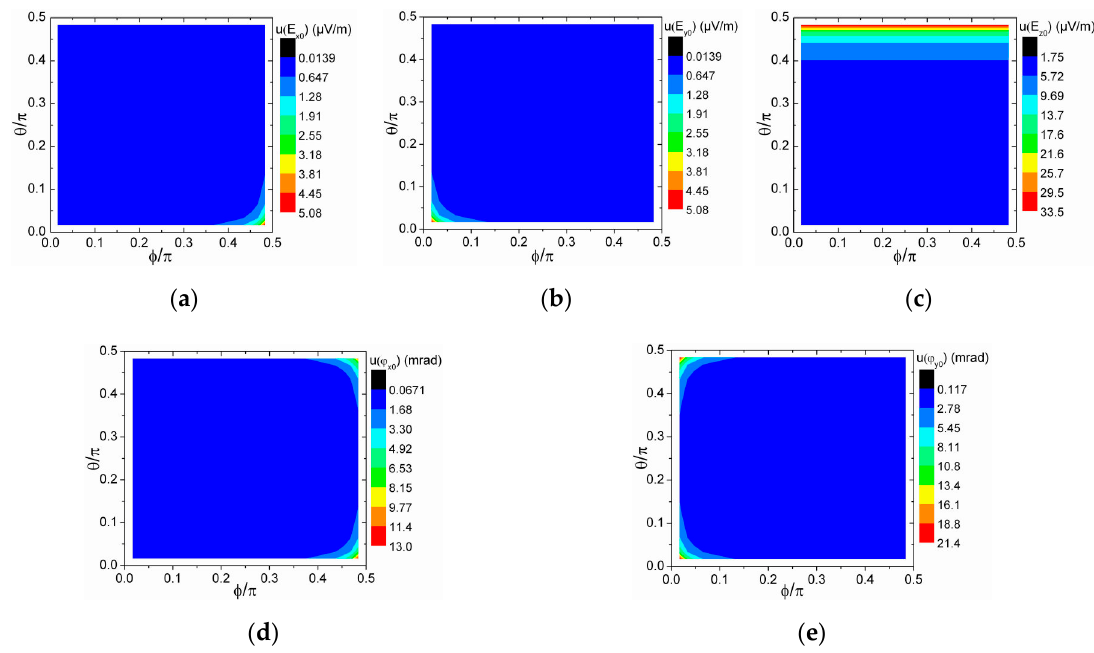
Figure 4. Estimated uncertainties of the amplitudes and phases of the components of the THz electric field in the LCF as a function of the spherical angles ( φ , θ ): ( a ) Uncertainty of E x,0 ; ( b ) Uncertainty of E y,0 ; ( c ) Uncertainty of E z,0 ; ( d ) Uncertainty of φ x,0 ; ( e ) Uncertainty of φ y,0 .